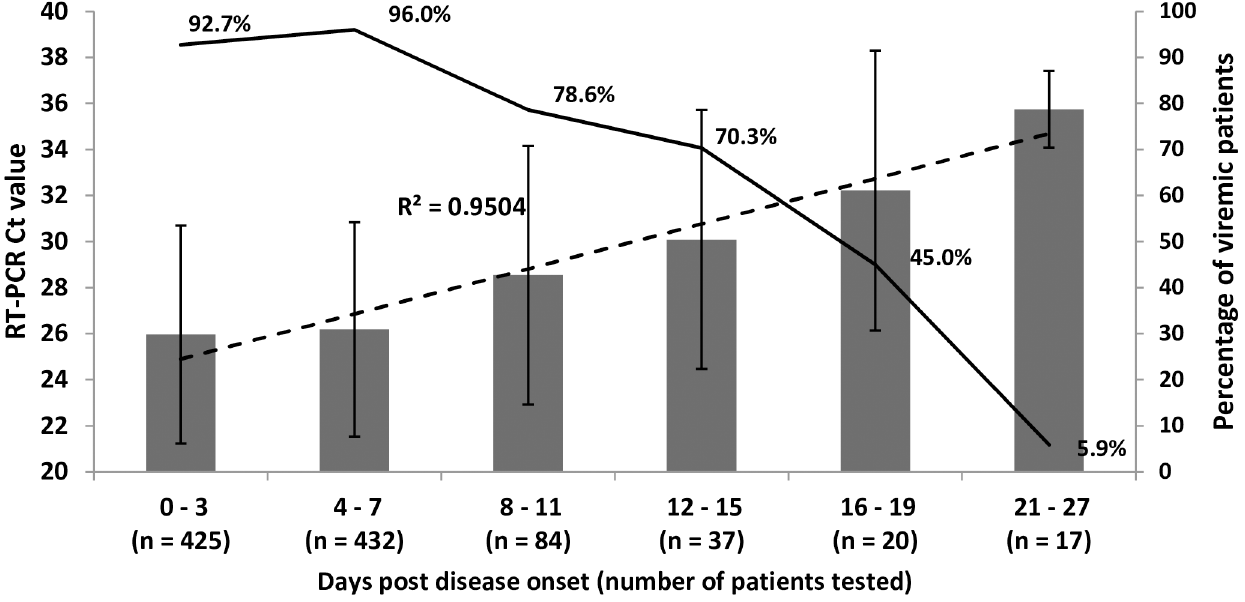
Fig 6. EBOV L-gene RT-PCR Ct values in sera of EVD patients tested at different days after disease onset and percentage of viremic cases. Solid column—mean ± 1SD Ct value; Dotted line—lineral correlation(R 2 ) betweenCt values and days post onset; Solid line—percentage of viremic patients. Ct value > 33.7 indicatesnon-viremicpatient